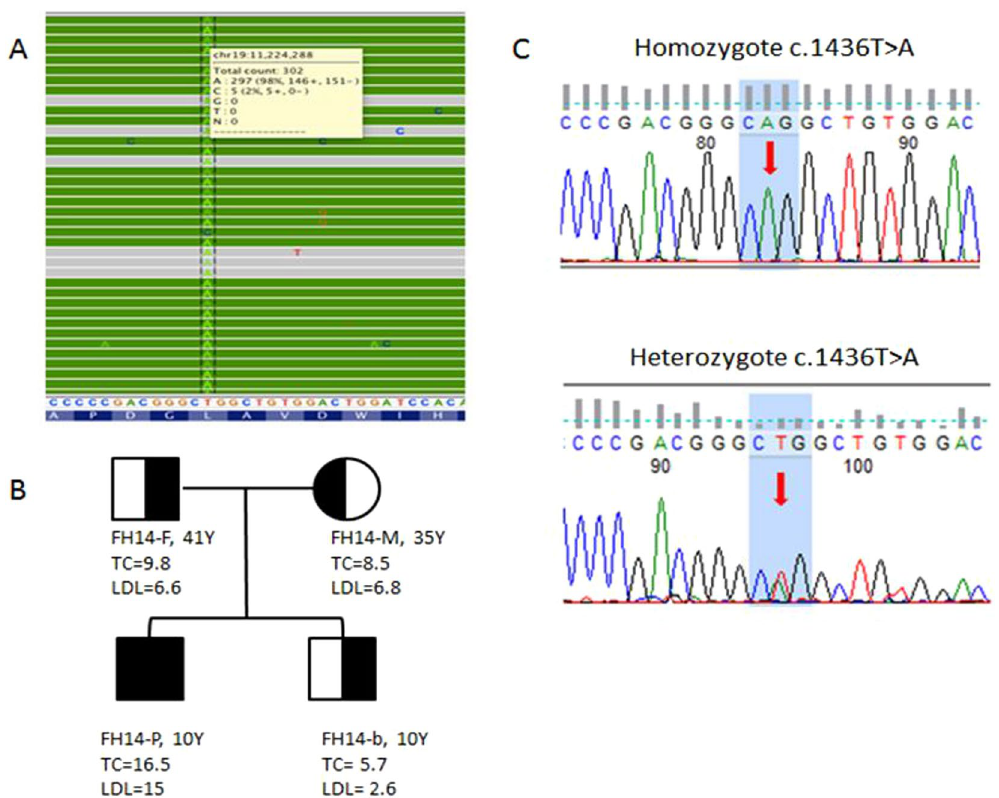
Figure 2. Co-segregation analysis of family with LDLR novel mutation p(.Leu479Gln). ( A ) NGS sequencing reads alignment using Integrated Genomics Viewer (http://software.broadinstitute.org/software/igv/) for proband FH14-P reports a variant at exon 10 of the LDLR gene [c.1436 T > A, p(.Leu479Gln)], the calling rate A allele of the variant is 95% which indicates the proband is a homozygote for the variant. ( B ) Co-segregation analysis of the FH14 family shows the 3 other family members are heterozygotes of the variant. ( C ) Sanger sequencing shows a base change between homozygote and heterozygote inherited